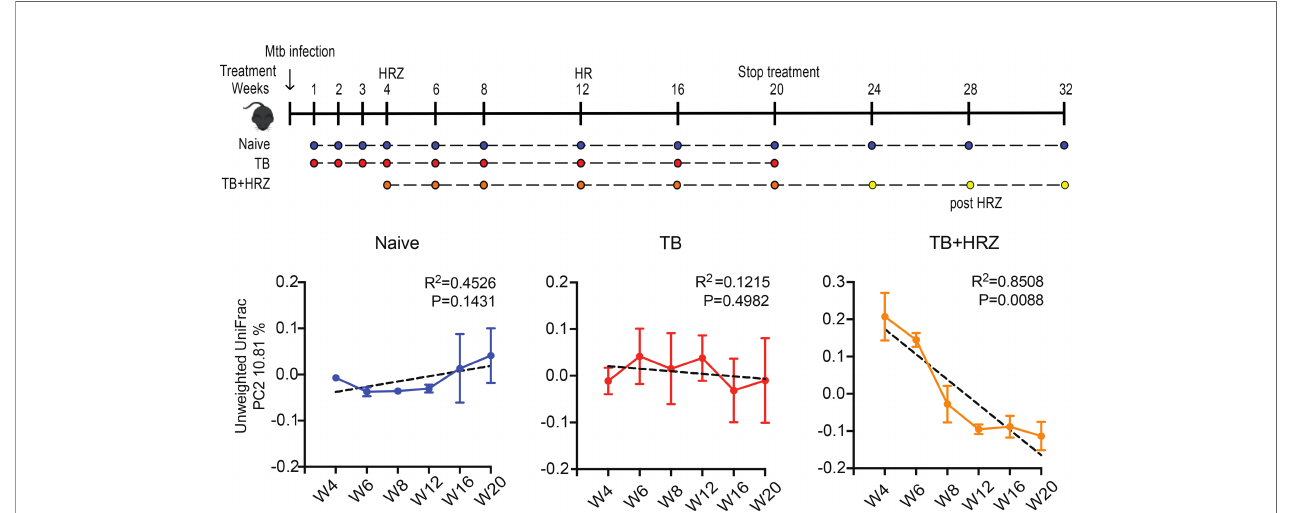
FIGURE 1 | In the mouse model, TB fi rst-line drugs induce a distinct and long lasting dysbiosis. X-axis = weeks of treatment; Y-axis = bacterial diversity; TB = TB infected, HRZ = isoniazid+rifampin+pyrazinamide treated (Namasivayam et al.,